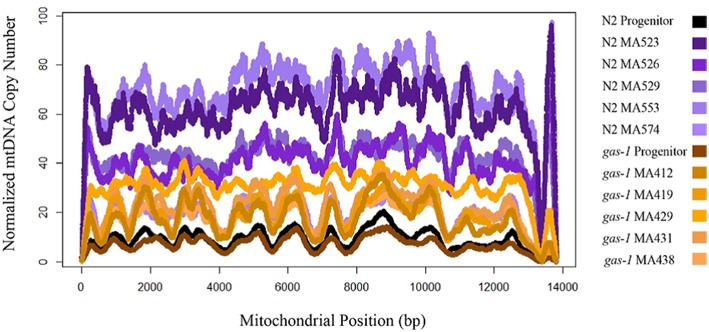
mtDNA copy number N2 and gas-1 progenitor vs. MA lines. All nematodes at L1 stage. N2 MA lines bottlenecked for 250 generations. gas-1 MA lines bottlenecked for a maximum 50 generations. mtDNA copy number normalized by corresponding line-specific coverage of single-copy nuclear genes: ama-1, ego-1, and efl-3. N2 MA lines mean mtDNA copy number = 47.43; standard deviation = 19.9. gas-1 MA mean mtDNA copy number = 12.89, standard deviation 5.63. The AT-rich region was excluded from analysis.